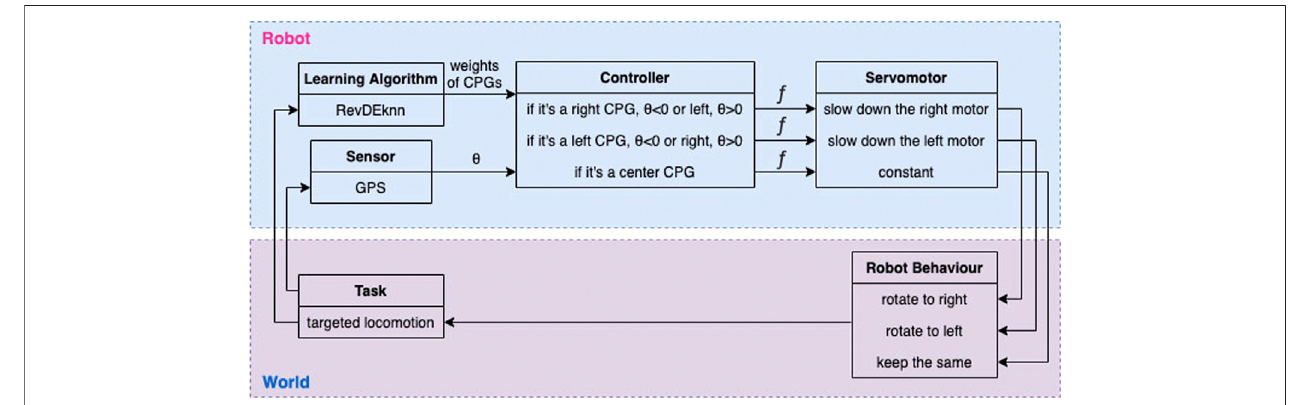
FIGURE 3 | The overall architecture of how steering affects the joints. Error angle θ is calculated using the coordinates of the robot, its current heading, and its target. Function f ( Eq. 5 & 6 ), which uses the output of the CPGs and θ , is then used to calculate the fi nal signal going to the joints.